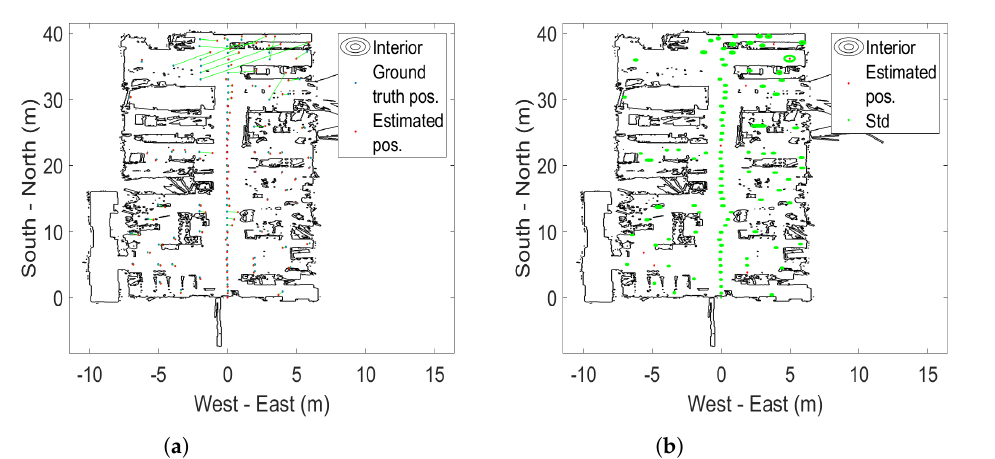
Figure 3. Static case results for Pozyx at 1m altitude. ( a ) Estimated positions from Pozyx (red) vs. ground-truth (blue) with connecting line (green). ( b ) Estimated positions from Pozyx (red) and standard deviation ellipsoids (green).